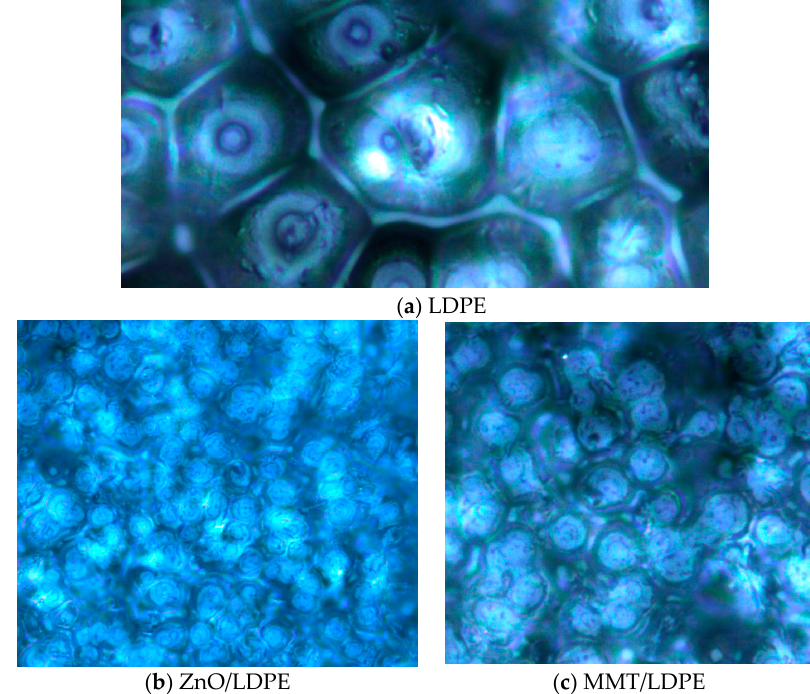
Figure 7. The PLM pictures of different samples.